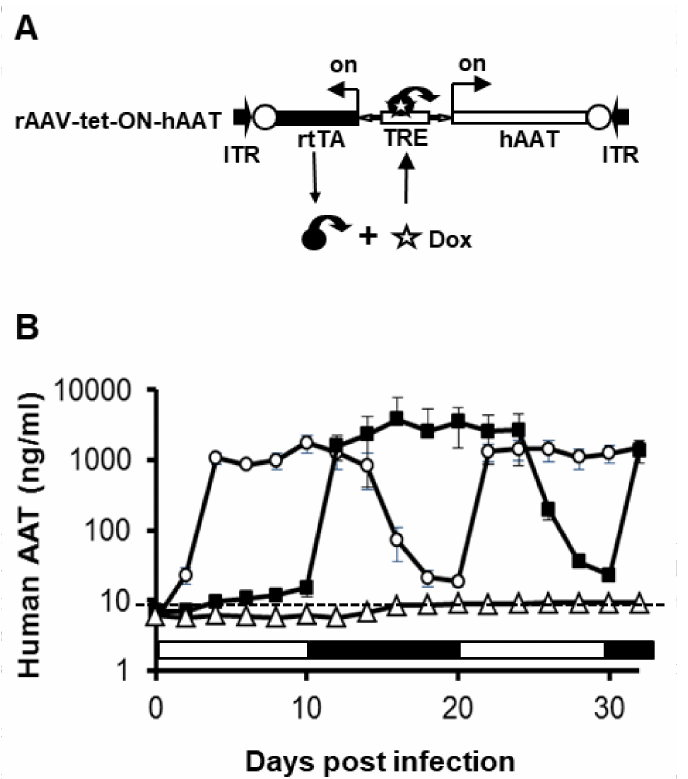
Figure 1. Transgene expression from recombinant adeno-associated virus (rAAV)1-tet-on-hAAT in di ff erentiated C2C12 cells. ( A ) The vector construct. ITR, AAV inverted terminal repeat sequences. TRE, tetracycline response elements. hAAT, hAAT cDNA. rtTA, reversed tetracycline transactivator gene. ( B ) hAAT levels detected in culture medium. Cell culture medium was collected and replaced every 2 days. The open circle group was cultured in medium with Dox (1 µ g / mL) for 10 days (day 0 to day 10 indicated by an open box), and then without Dox for 10 days (day 10 to day 20 indicated by a black box). The DOX treatment cycle was repeated after day 20. The filled square group was cultured in medium without Dox for 10 days (day 0 to day 10 indicated by open box), and then with Dox for 10 days (day 10 to day 20 indicated by black box). This DOX treatment cycle was also repeated. The experiment ended on day